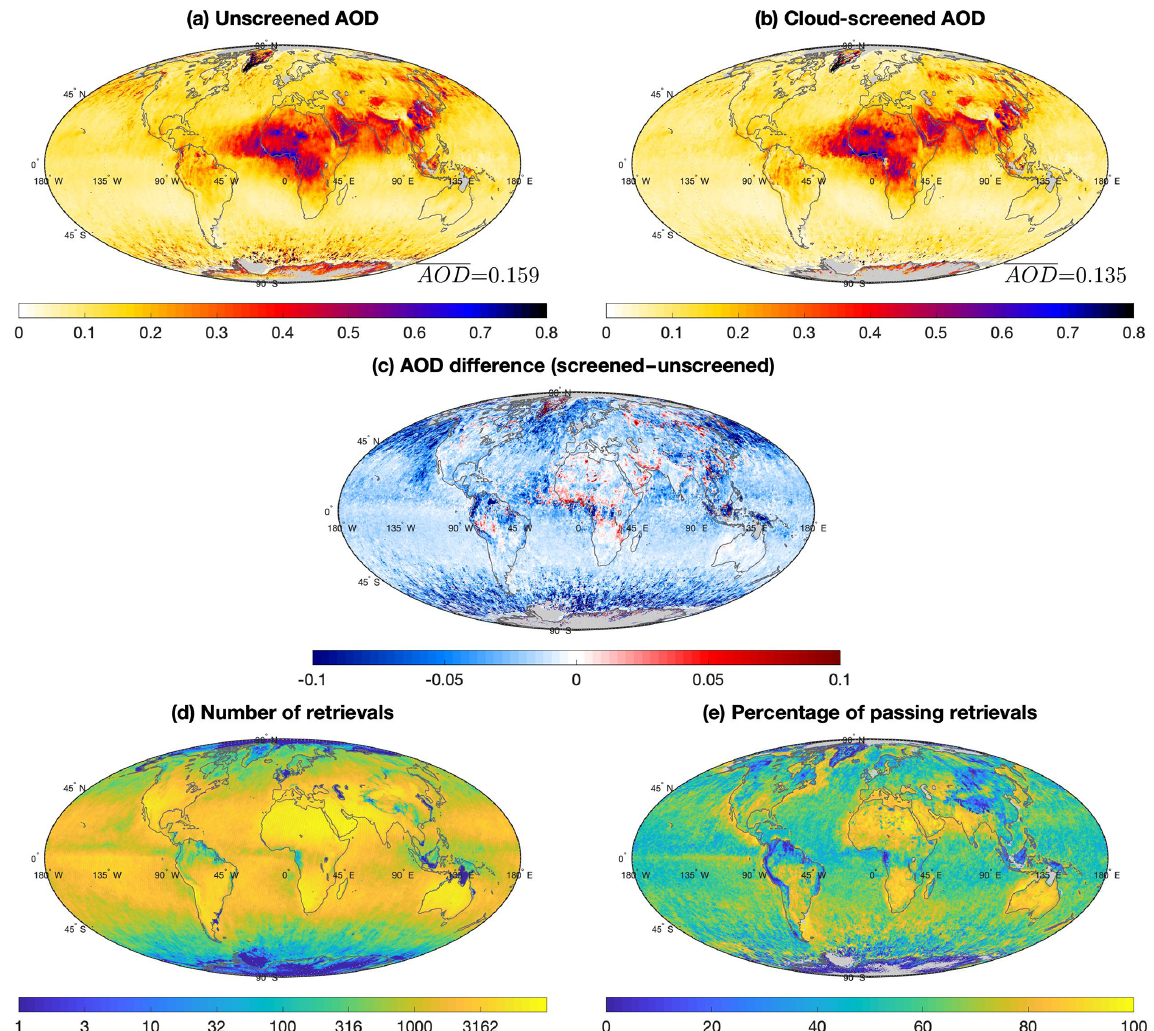
Figure 1. Effects of additional cloud screening implemented operationally in V23 shown using 0.5 ◦ gridded retrievals from 2012: (a) global AOD distribution prior to additional cloud screening, (b) global AOD distribution with operational cloud screening, (c) AOD difference between the screened and unscreened data;, (d) number of retrievals (unscreened) in each grid box, and (d) percentage of retrievals remaining after cloud screening. Average AOD values in (a) and (b) are